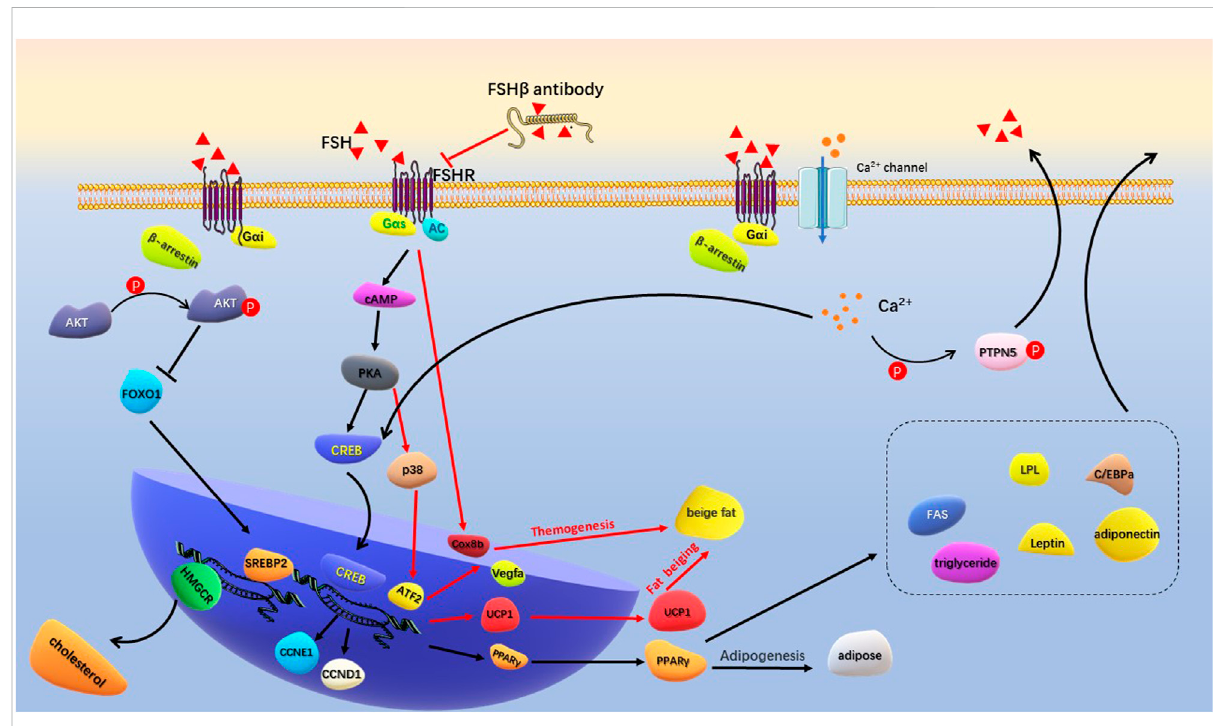
FIGURE 3 Schematic diagram of FSH regulating adipogenesis. FSH binds to Gas-coupled FSHR to activate the classical cAMP/PKA/CREB pathway. Increased PPAR γ transcription promotes production oflipidandaseries oflipogenic factors.Speci fi cFSH β antibodiesinhibitFSH-FSHRinteractions, activate transcription of Cox8b, Vegfa, and UCP1 to promote beige fat production and thermogenesis. FSH binds to G α i-coupled FSHR to activate Ca 2+ channel. Intracellular calcium in fl ux promotes lipid generation by activating the CREB pathway, and assists GnRH in promoting FSH secretionbyphosphorylationofPTPN5.ThebindingofFSHtoG α i-coupledFSHRactivatesp-Aktinthepresenceof β -arrestin.ByinhibitingFoxO1,it promotes the transcription of SREBP-2 and HMGCR genes to produce